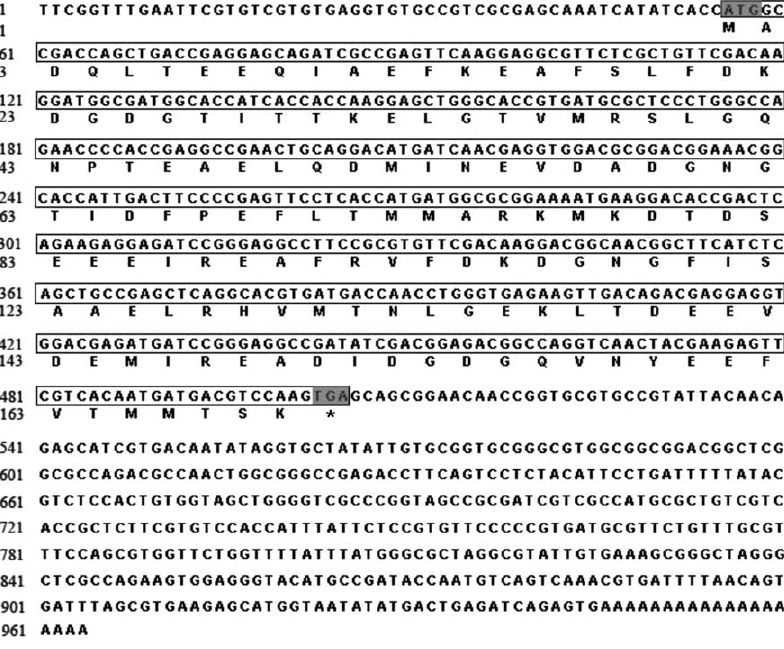
Figure 1. The complete nucleotide and deduced amino acid sequences of CaM in B.amphitrite . The nucleotides and amino acids are numbered on the left of the sequences. The sequences in the box show the whole open reading frame. An asterisk (*) represents the stop codon at the end of the coding sequence.